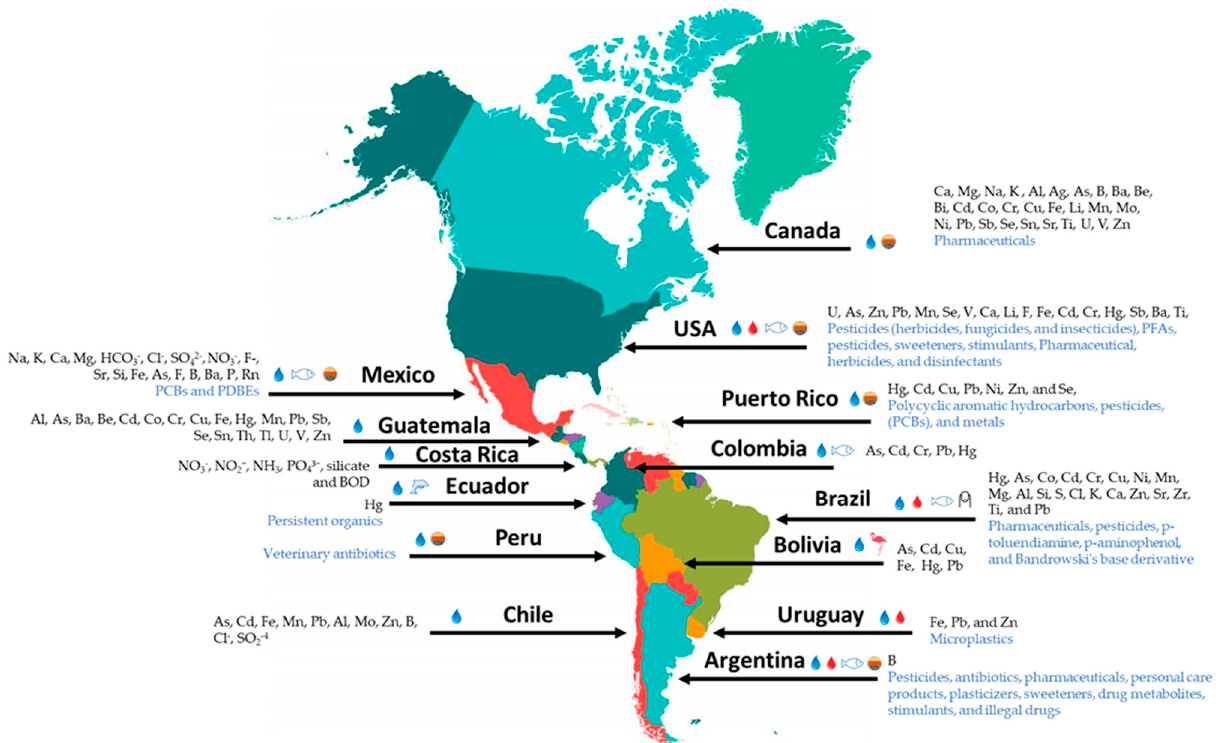
Figure 1. Geographical distribution of pollutants detected in the American continent in different matrices (water, blood, sediments, biota) in the last 5 years.